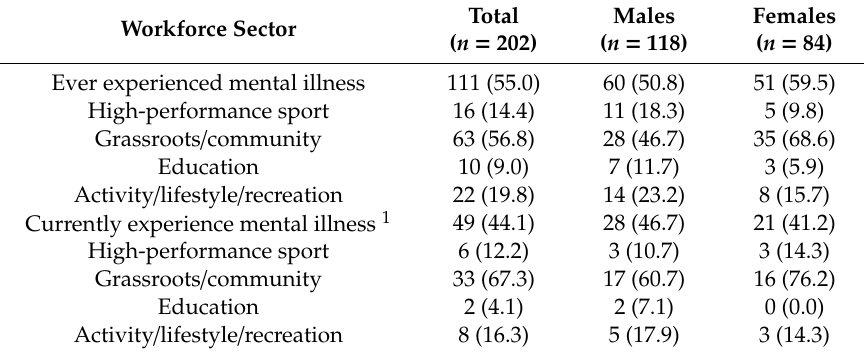
Table 2. Workforce sector-related experience of mental illness ( n and